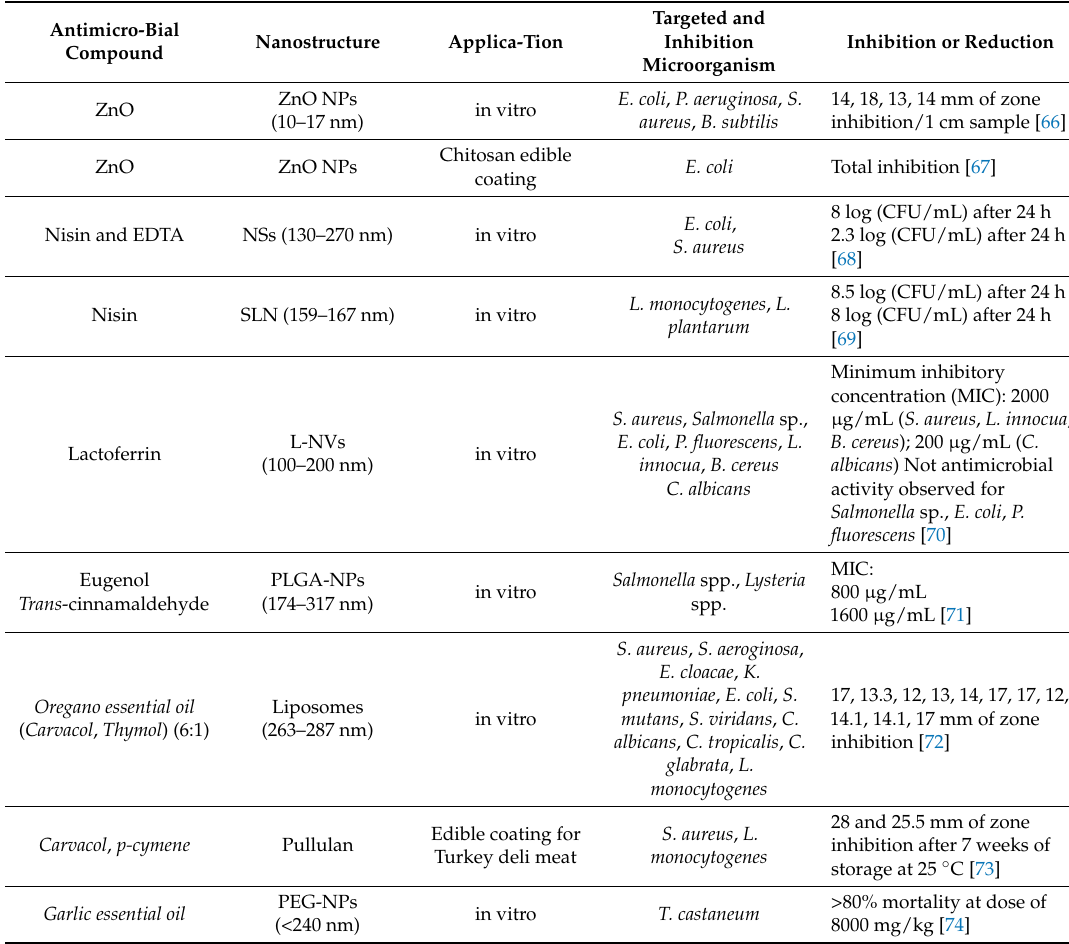
Table 2. Recent studies of the functionalization of nanostructures with antimicrobials. Antimicro-Bial